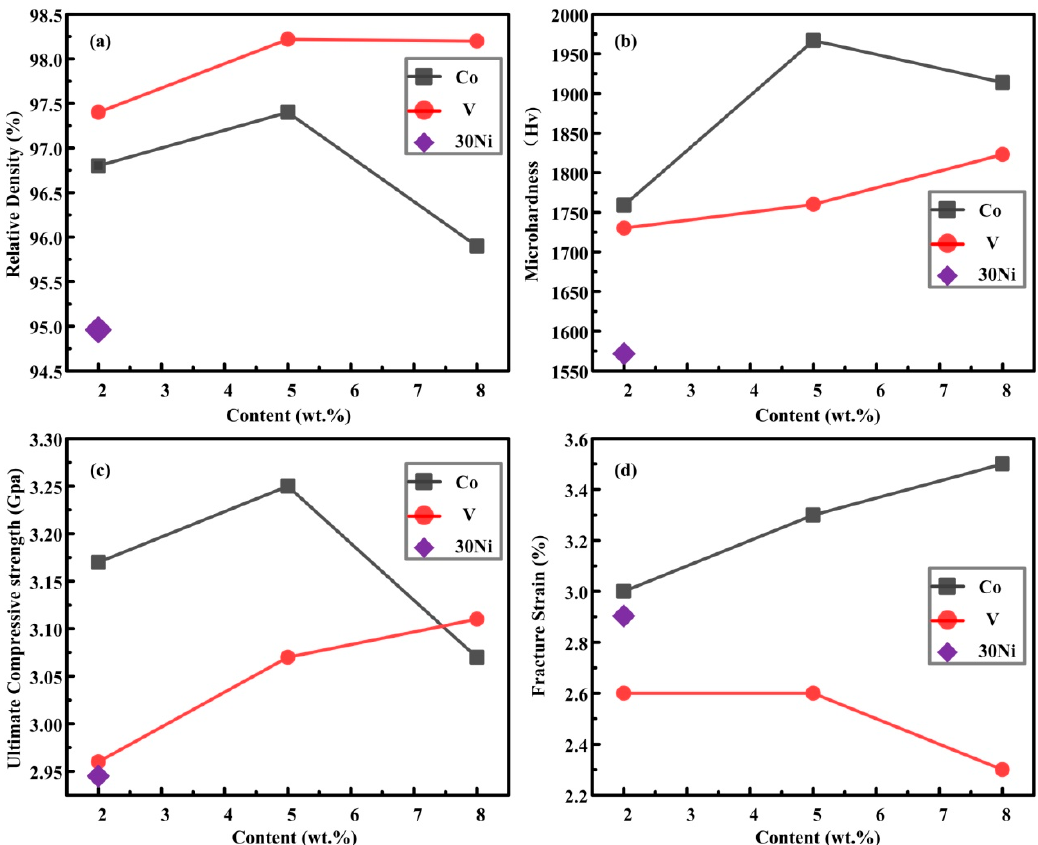
Figure 13. Variations of ( a ) relative density, ( b ) microhardness (Hv), ( c ) ultimate compressive strength σ UGS and ( d ) fracture strain ε f of (TiC x N y –TiB 2 )/Ni cermets with different Co/V contents.